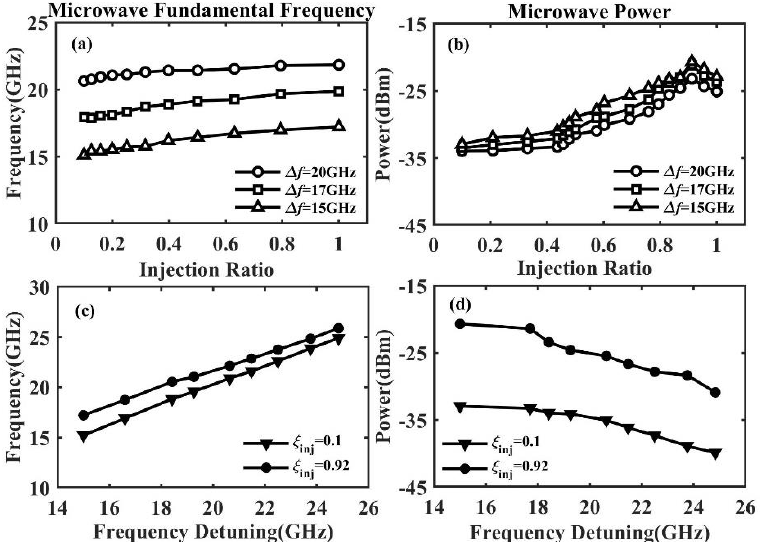
Figure 4. ( a ) Frequency and ( b ) power of the generated microwave as a function of injection ratio; ( c ) frequency and ( d ) power of the microwave versus frequency detuning. ( c ) frequency and ( d ) power of the microwave versus frequency